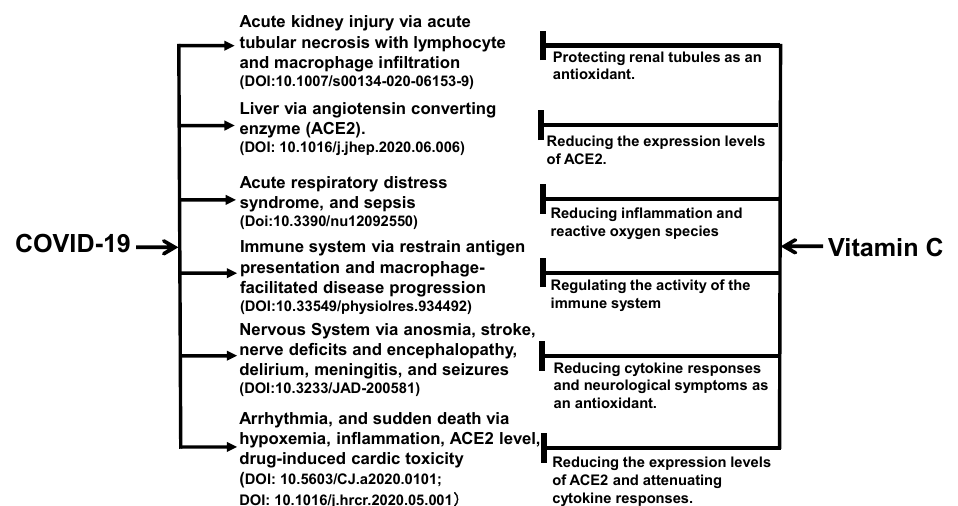
Figure 1. Ascorbic acid has been experimentally proven to ameliorate comorbid conditions in SARS-CoV-2-infected patients. Vitamin C appears to promote immune function and reduce inflammation and oxidative stress, and in turn, protect multiple organs in patients with COVID-19. As an antioxidant, vitamin C prevents acute necrosis mediated by immune cells in the kidneys. For the lungs, heart, liver, vitamin C reduces the expression levels of angiotensin converting enzyme 2 (ACE2) expression levels, which limits the binding of the viral particles to the cells. For the kidneys, it prevents the development of acute kidney injury. For the immune system, its autophagy-inducing mechanism impedes the severity of COVID-19 by producing interferons and decreasing the levels of inflammatory interleukins.